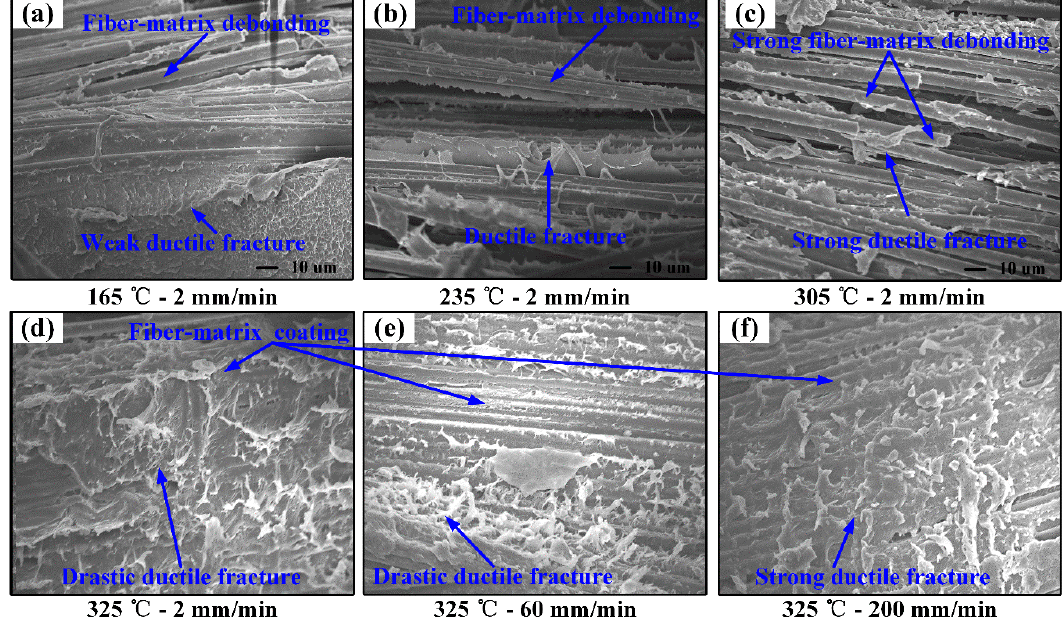
Figure 9. SEM images of the fracture surfaces of woven CF/PEEK composites after flexural testing under different conditions: ( a ) 165 °C—2 mm/min, ( b ) 235 °C—2 mm/min, ( c ) 305 °C—2 mm/min, ( d ) 325 °C—2 mm/min, ( e ) 325 °C—60 mm/min, and ( f ) 325 °C—200 mm/min.